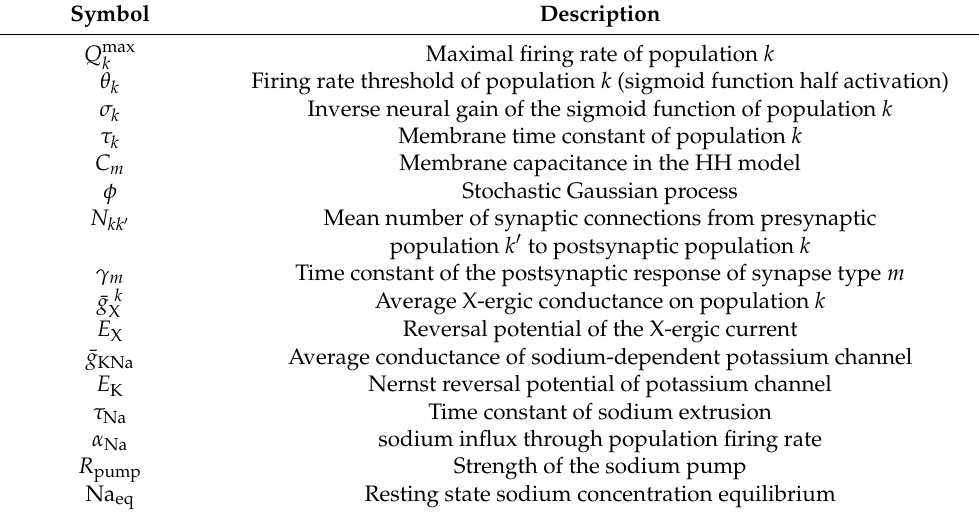
Table 1. Parameter description for the neural mass